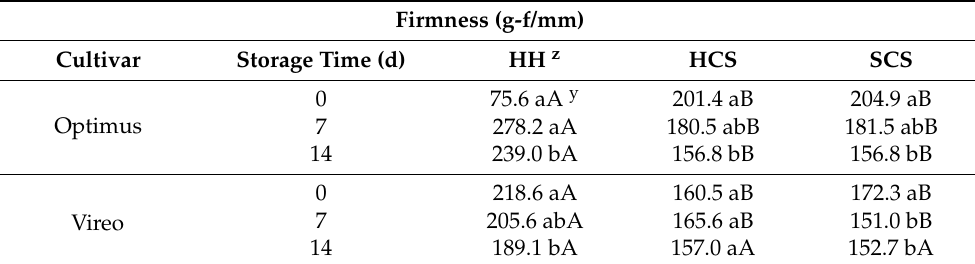
Table 6. Fruit firmness during storage for 14 d at 1 ◦ C for “Optimus” and “Vireo” blueberries, after hand harvest or mechanical harvest onto hard- or soft-catch surfaces and commercial packing. Harvest